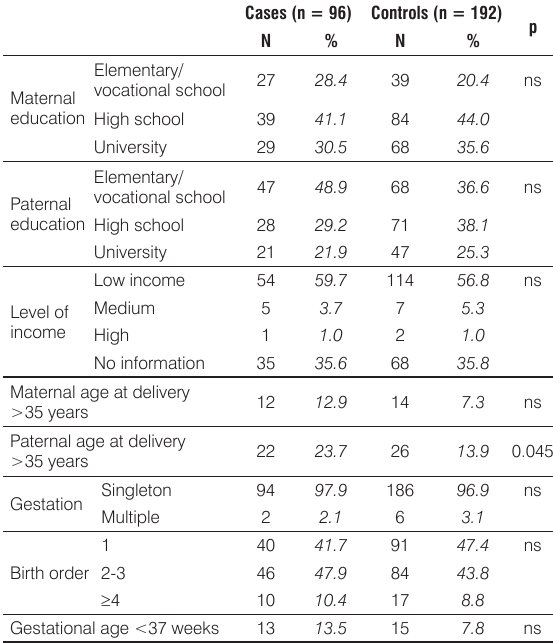
Table 1. Prenatal characteristics of cases and